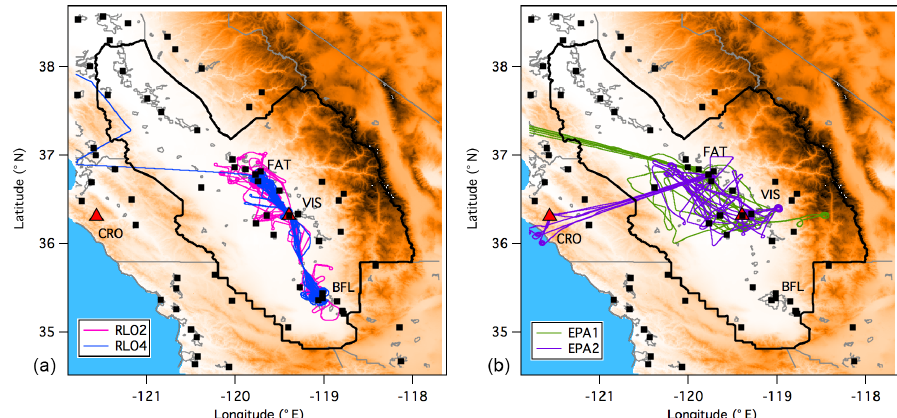
Figure 6. (a) Map of the San Joaquin Valley showing the RLO flight tracks coincident with the TOPAZ measurements (RLO2 and RLO4). The filled black squares show the regulatory surface monitors. The CABOTS sampling sites at CRO and VMA are marked by red triangles. The other abbreviations are the Fresno (FAT), Visalia (VIS), and Bakersfield (BFL) airport codes. Note that VMA and VIS refer to the same airport. (b) The same as (a) but with the EPA flight tracks (EPA1 and EPA2).